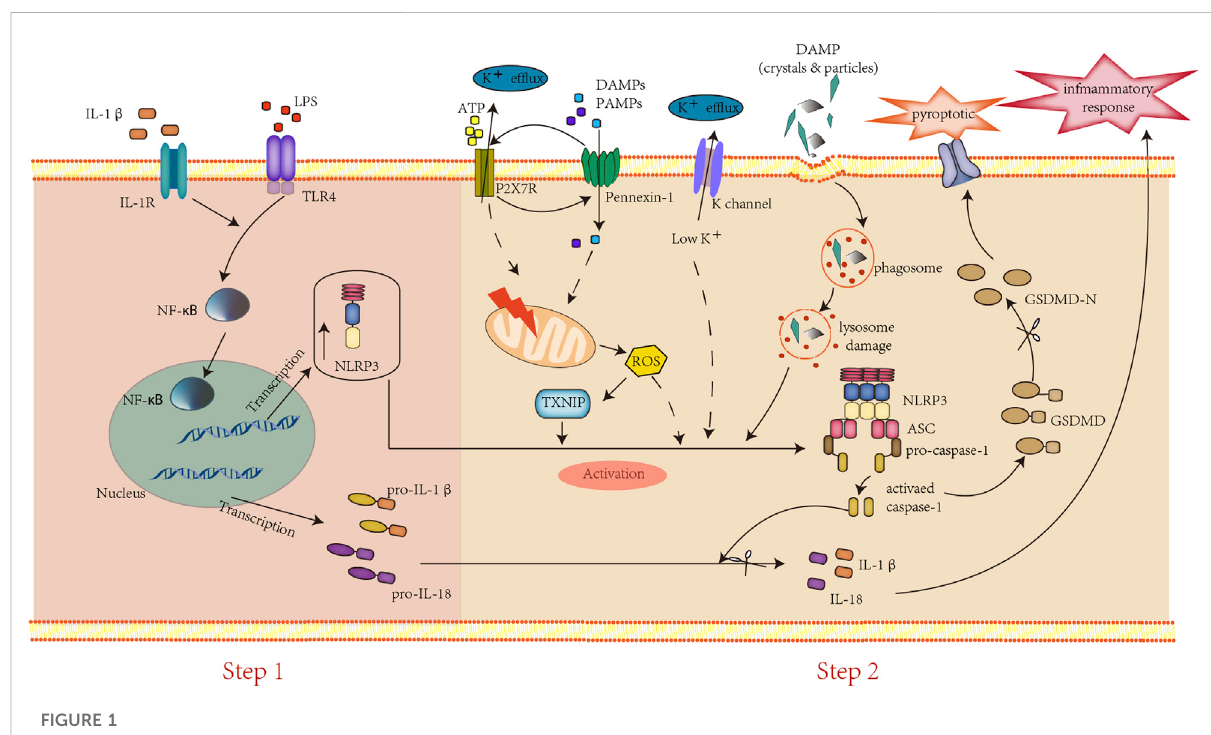
FIGURE 1 Assemble and activation of the NLRP3 in fl